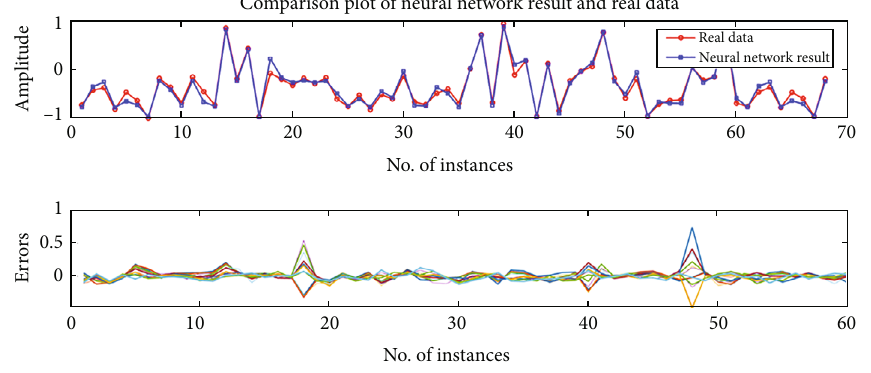
Figure 13: Results comparison of the neural network and train